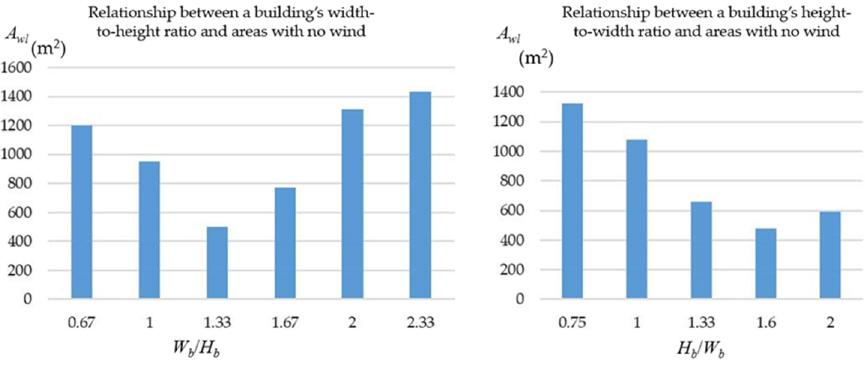
Figure 13. Relationship between a building’s height-to-width (width-to-height) ratio and areas with no wind.